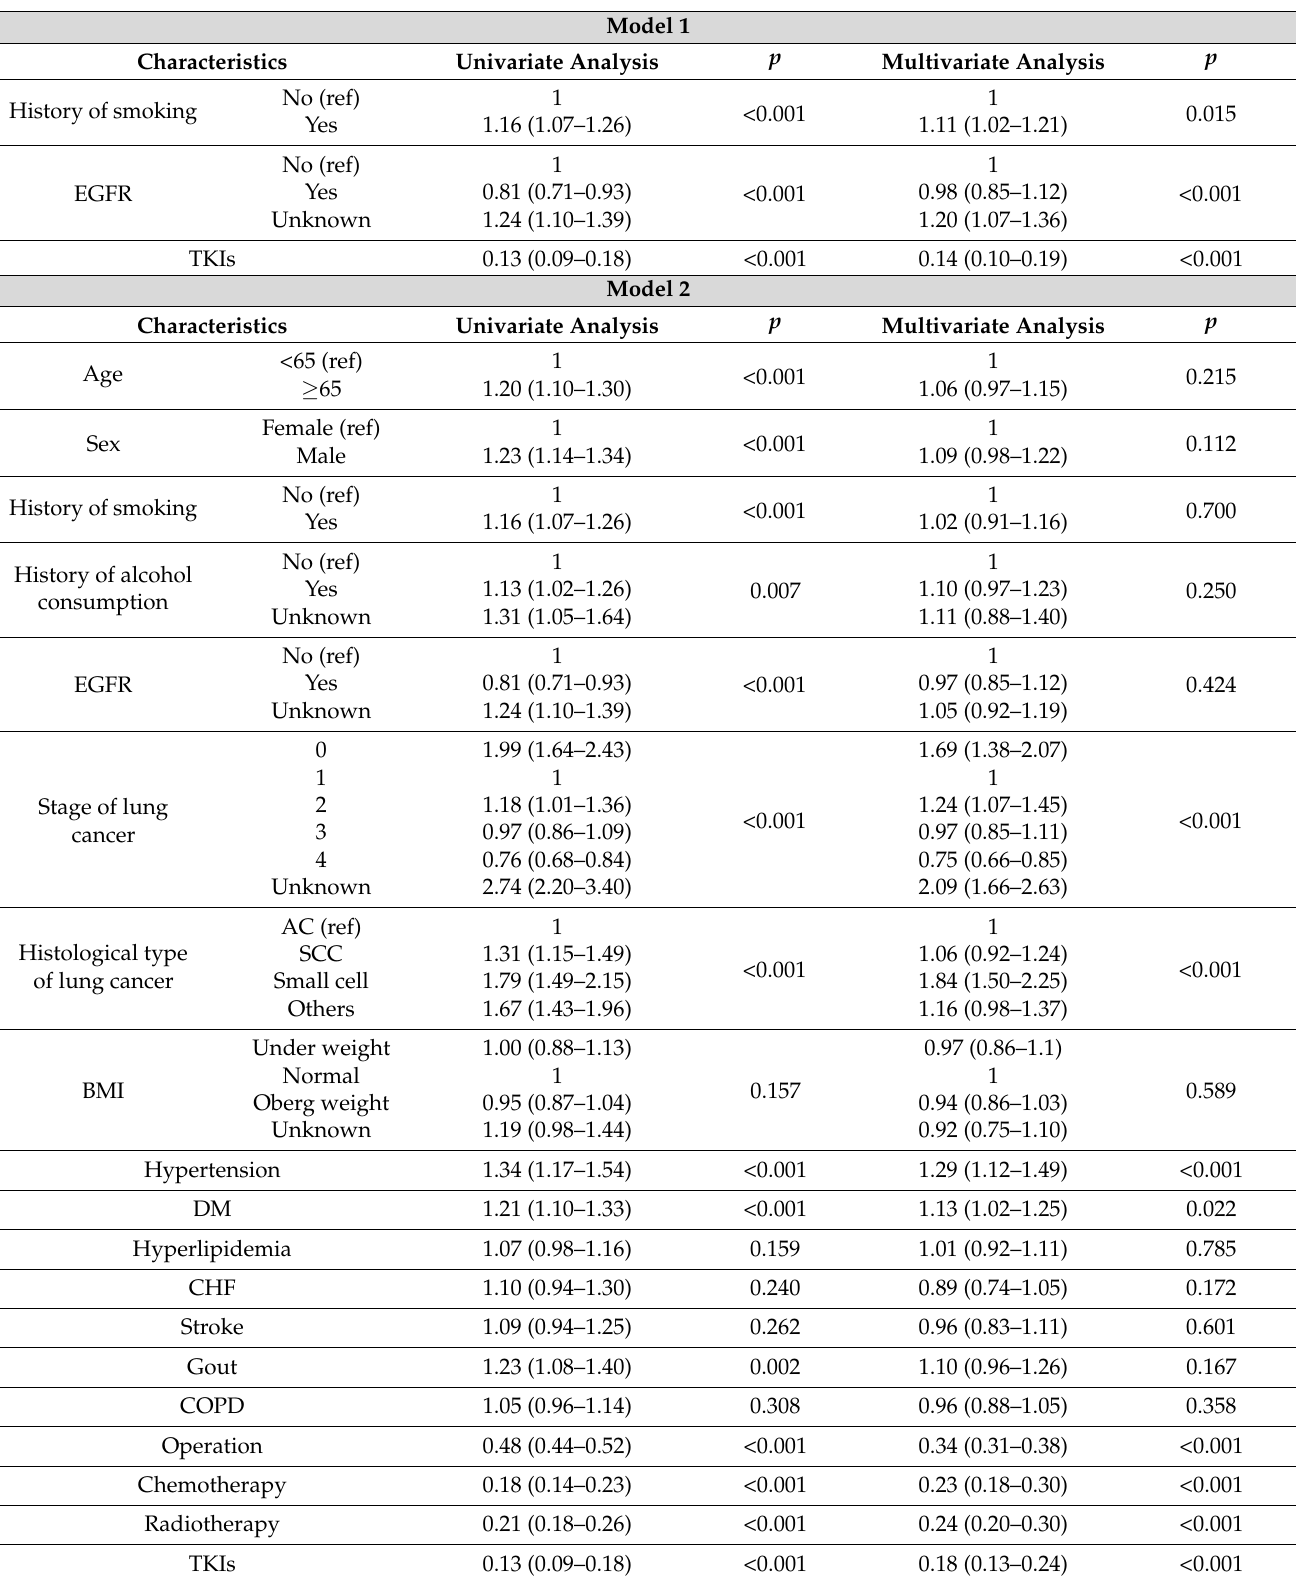
Table 4. The univariate and multivariate Cox proportional hazard models after excluding patients with unknown smoking